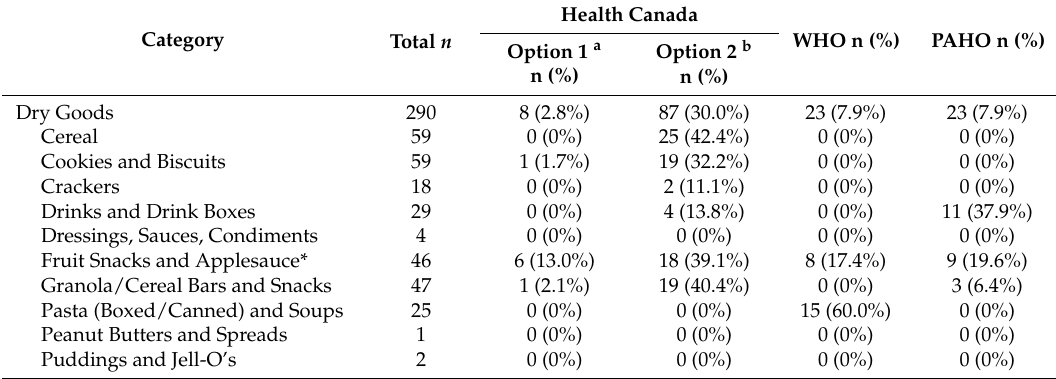
Table 3. Number of food products allowed to be marketed to children according to the Health Canada, WHO, and PAHO models ( n = 374